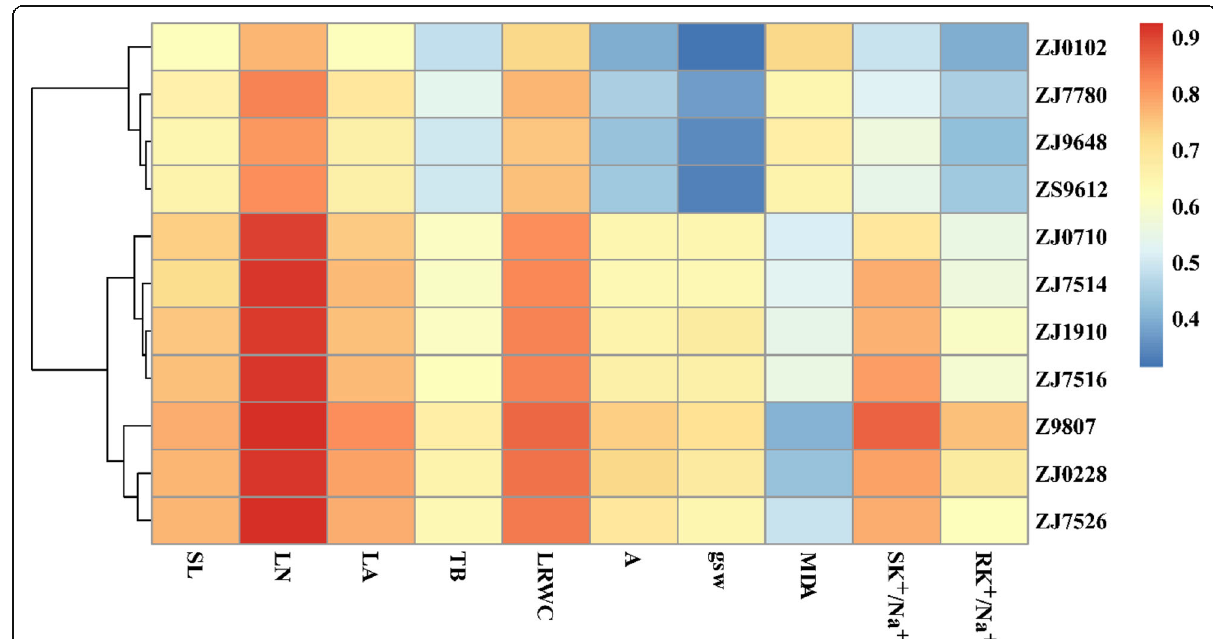
Fig. 5 Cluster heat map analysis of eleven cotton genotypes for salt